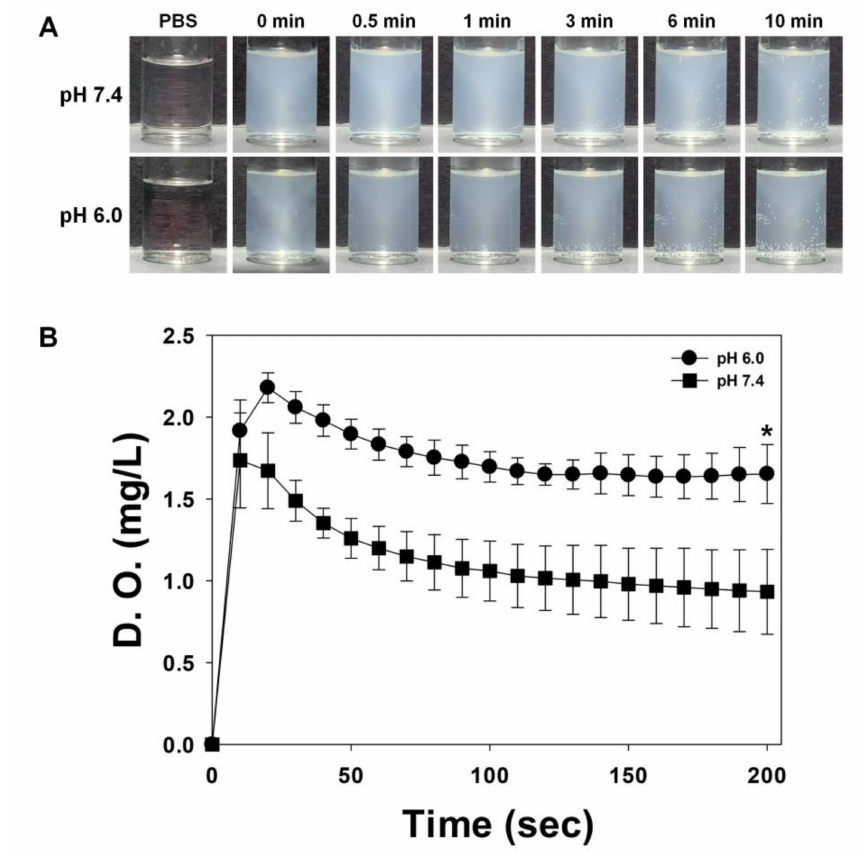
Figure 5. ( A ) Representative photographs of oxygen bubbles generated upon hydrolysis of TA (10 mg) / CaO 2 at pH 7.4 and 6.0. ( B ) Oxygen concentrations in suspensions of the TA (10 mg) / CaO 2 nanoparticles, as measured using a portable dissolved oxygen meter. The data represent mean ± SD (n = 3). * p <